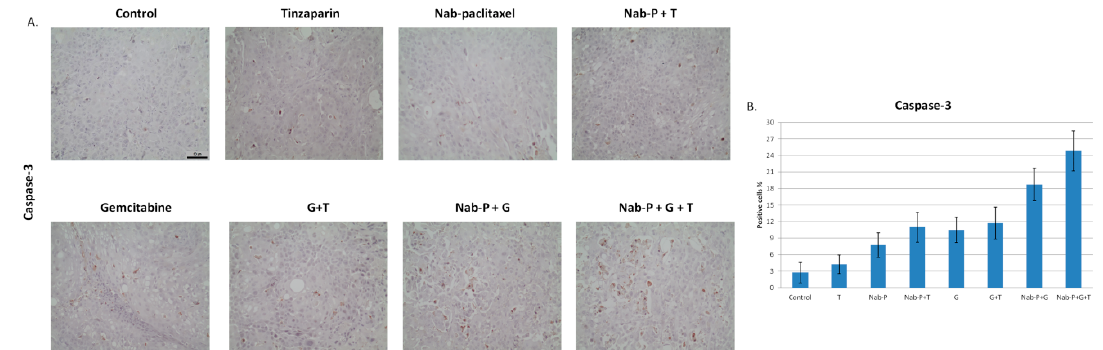
Figure 5. Tinzaparin induces apoptosis when administered as part of conventional double or triple drug regimes. ( A ) Immunohistochemistry with anti-caspase-3 antibody at 4 μ m paraffin sections. Representative photos of each group (control, tinzaparin, nab-paclitaxel, nab-paclitaxel + tinzaparin, gemcitabine, gemcitabine + tinzaparin, nab-paclitaxel + gemcitabine, nab-paclitaxel + gemcitabine + tinzaparin) 200× magnification, scale bar = 50 μ m. ( B ) The diagram shows the percentage of positive cells for caspase-3. n = 10/group. All data represent mean ± SD.